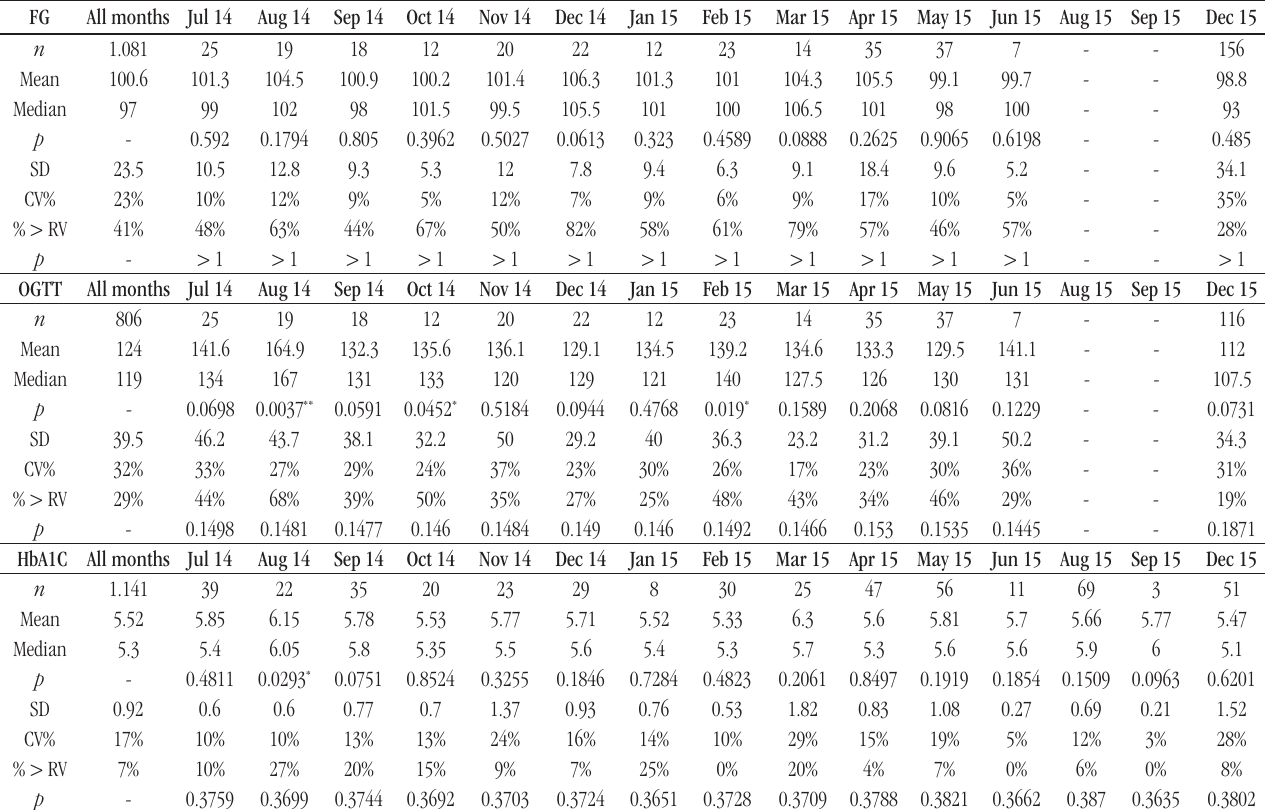
taBLE − Descriptive statistics of mean, median and values above RV over time for fasting glucose, post-glucose load, and HbA1C in the first months of the study FG All months Jul 14